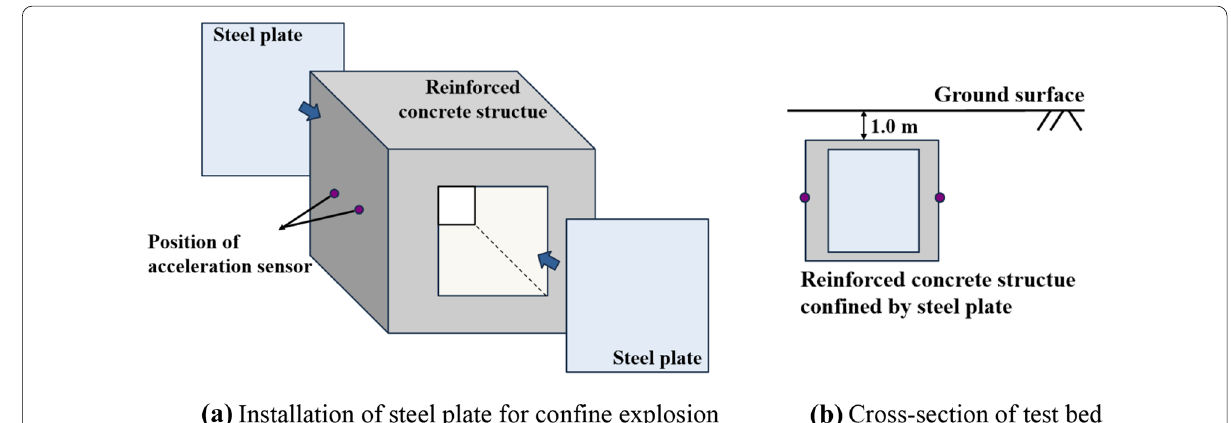
Fig. 6 Plan for explosion experiment in test